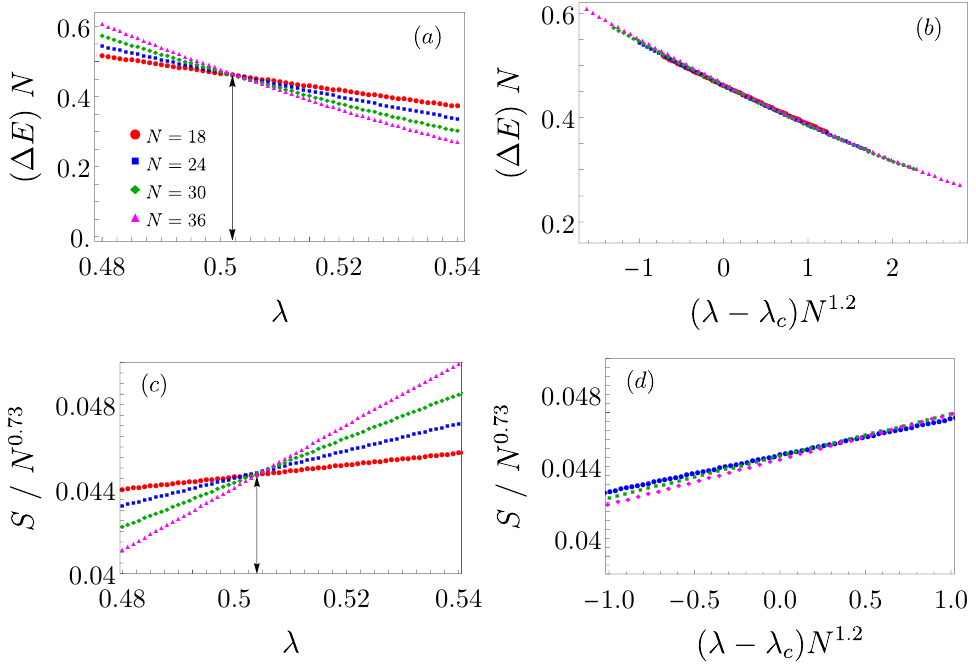
Figure 9: Exact numerics confirming the presence of the three-state Potts transition = 3. (a): Plot of ( ∆ E ) N z for a three-leg ladder as a function of λ for several for ℓ 0 ≃ 0.501 for z = 1. (b) Plot of ( ∆ E ) N z as a function N showing a crossing at λ = λ c ) showing perfect scaling collapse for z = 1 and ν ≃ 1 / 1.2 = 0.83.(c): of N 1 /ν ( λ − λ c ≃ 0.502 for η ≃ 0.27. (d) Plot of SN 2 − z − η as a function of λ showing a crossing at λ c ) N 1 /ν showing a scaling collapse for ν = 1 / 1.2 Plot of SN 2 − z − η as a function of λ − λ c and η = 0.27. All energies are scaled in units of ∆ . See text for